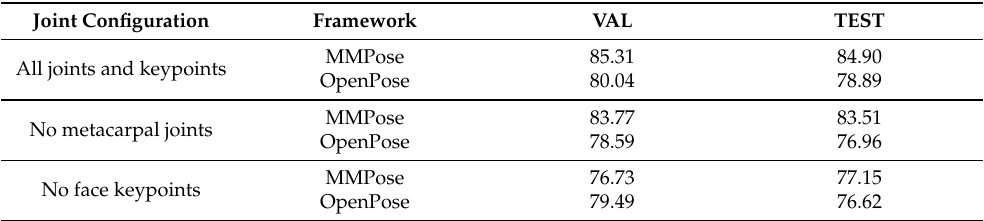
Table 6. Ablation of SPOTER performance on AUTSL depending on included joints. The experiments were performed with two pose estimation libraries (MMPose and